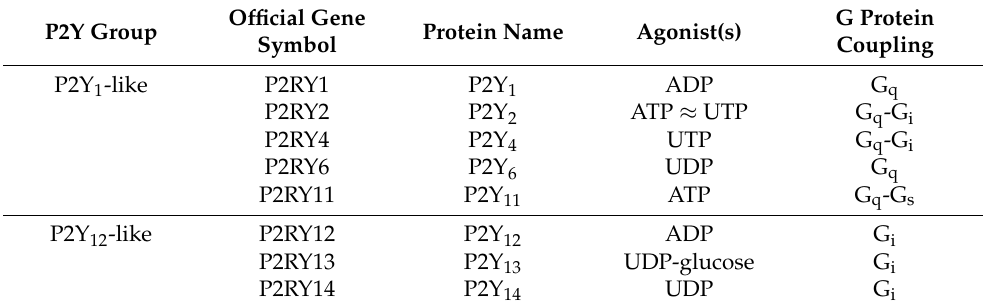
Table 1. Human P2Y